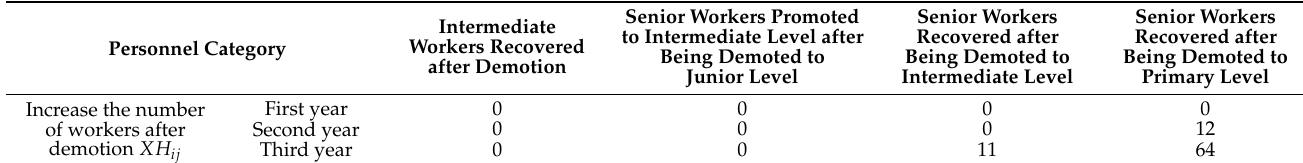
Table 13. Number of workers promoted after demotion in the lowest cost model for the past three